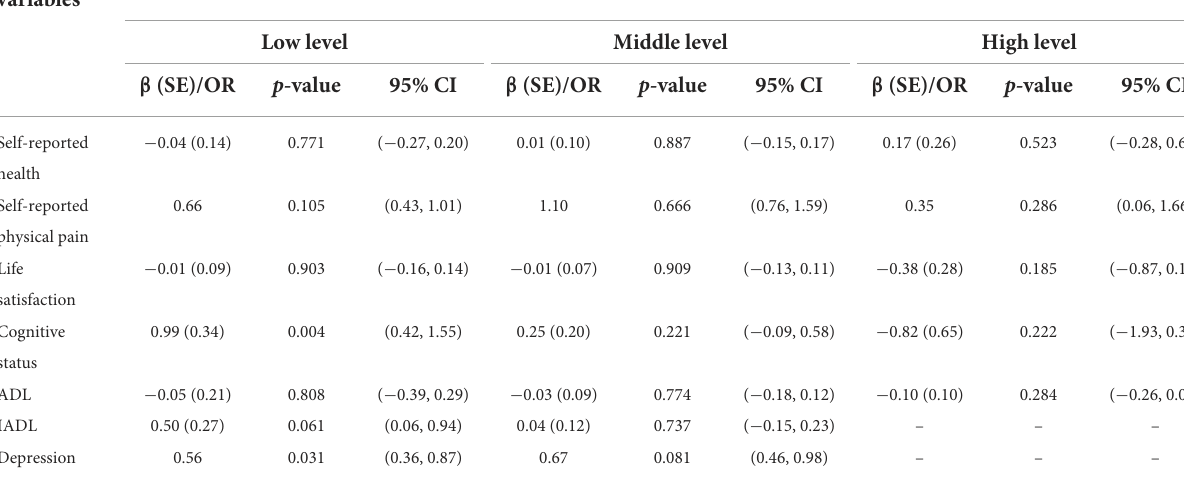
TABLE 5 Estimation of the intervention effect of retirement on the health of elderly women individuals of different education levels. Outcome